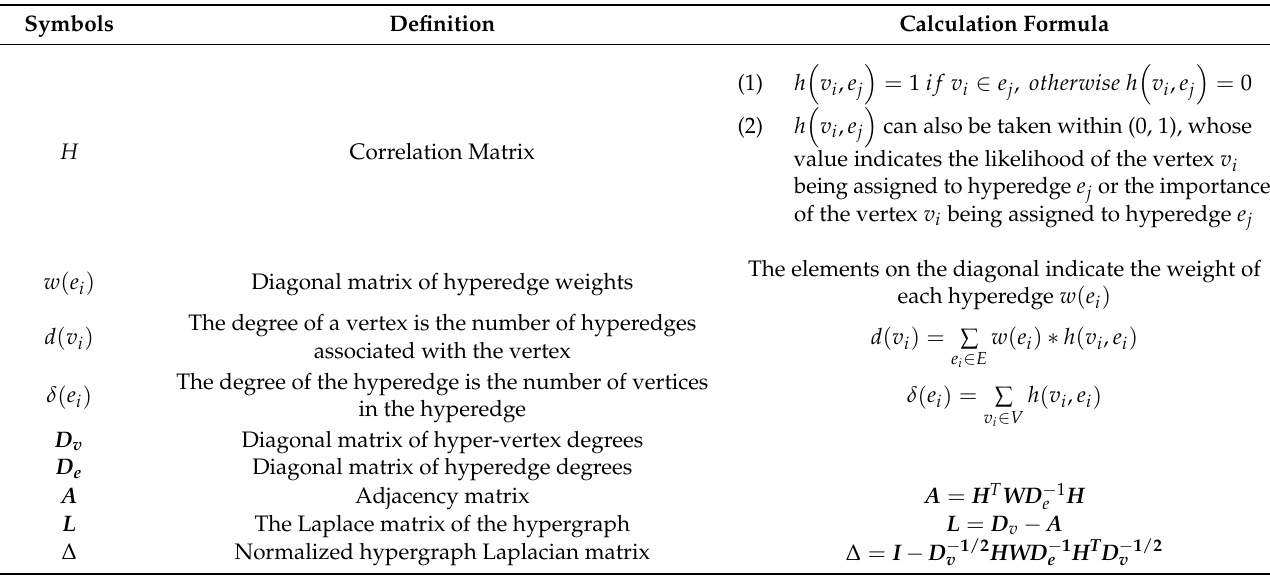
Table 2. Hypergraph symbol definition and calculation